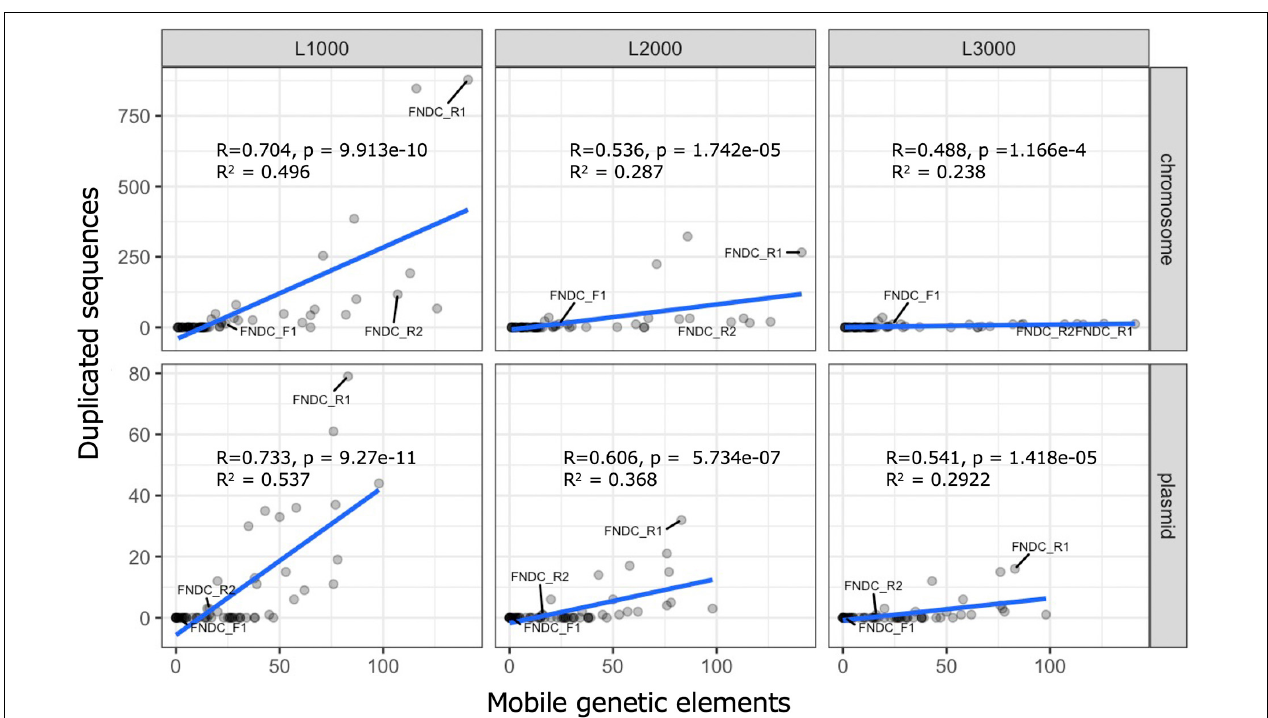
FIGURE 8 | Scatter plots for duplicated sequences and mobile genetic elements. These scatter plots show results of correlation and regression analysis of the number of duplicated sequences and mobile genetic elements in the genome. Correlation analysis and regression analysis were performed with functions implemented in R. The top and bottom rows, respectively, present results for chromosomes and plasmids. Columns L1000, L2000, and L3000, respectively, correspond to the conditions that set 1,000, 2,000, and 3,000 bp as the minimum length threshold during the duplicate sequence search. The line written in blue is the regression line. R , p , and R 2 , respectively, denote the correlation coefficient, the p -value of the uncorrelation test, and the multiple correlation coefficient.